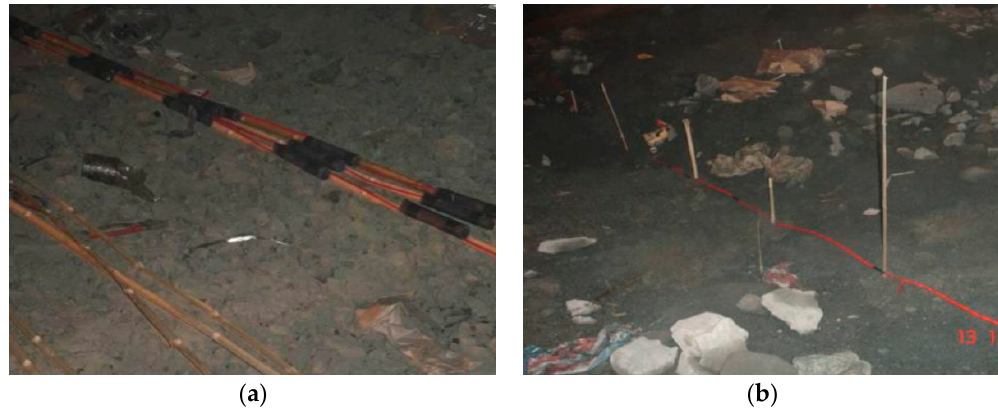
Figure 18. Field charge of pre-splitting blasting test; ( a ): Horizontal laying; ( b ) The network connection of pre-splitting blasting.